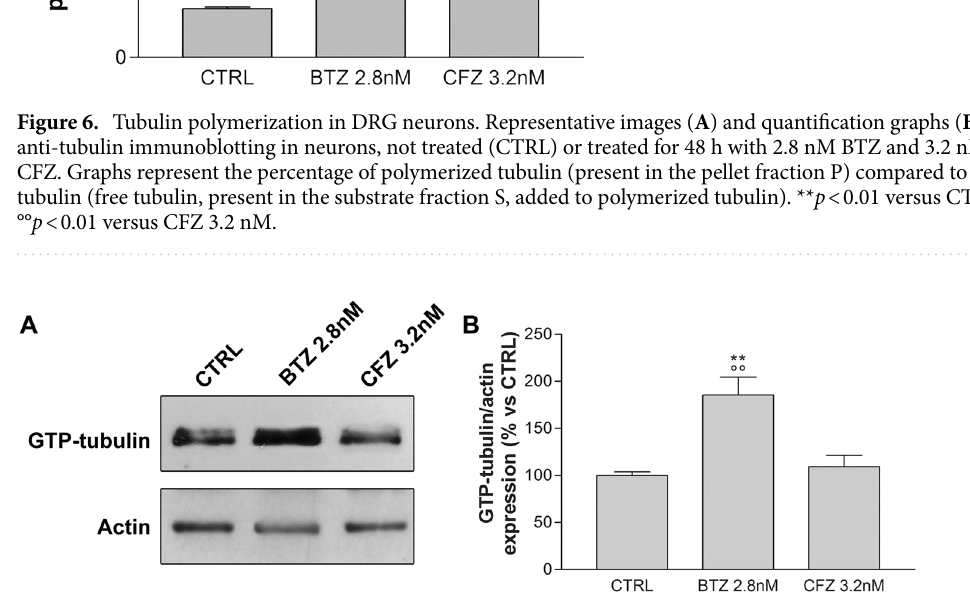
Figure 7. GTP-tubulin in sensory neurons. Representative image ( A ) and quantification graph ( B ) of GTP- tubulin immunoblotting in neurons not treated (CTRL) or treated for 48 h with 2.8 nM BTZ and 3.2 nM CFZ. Data are normalized respect to actin value and expressed as percentage respect control. **p < 0.01 versus CTRL; °°p < 0.01 versus CFZ 3.2